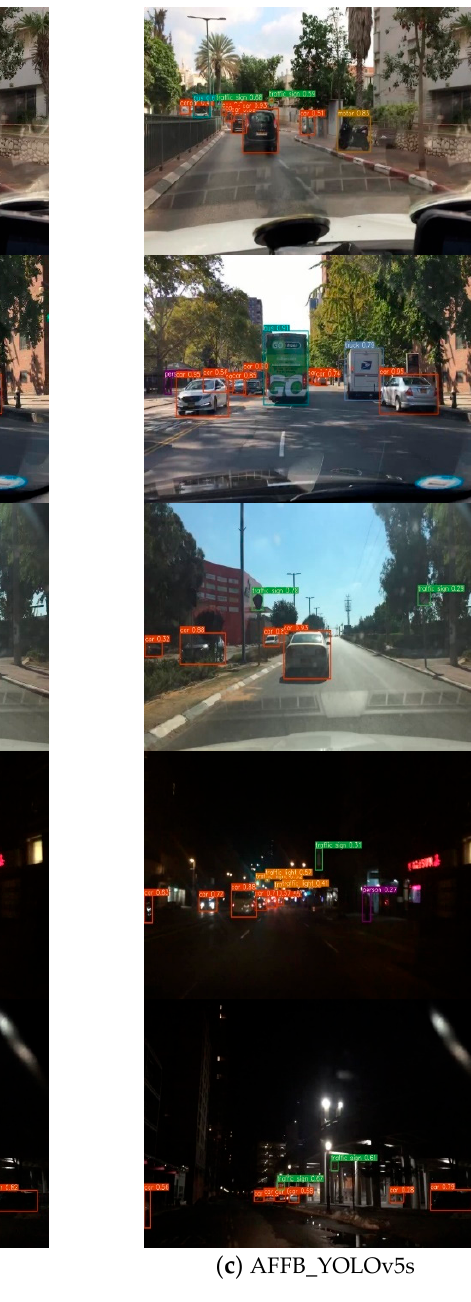
Figure 11. Comparison of the detection results of YOLOv5s, MS-CAB_YOLOv5s, and AFFB_YOLOv5s .